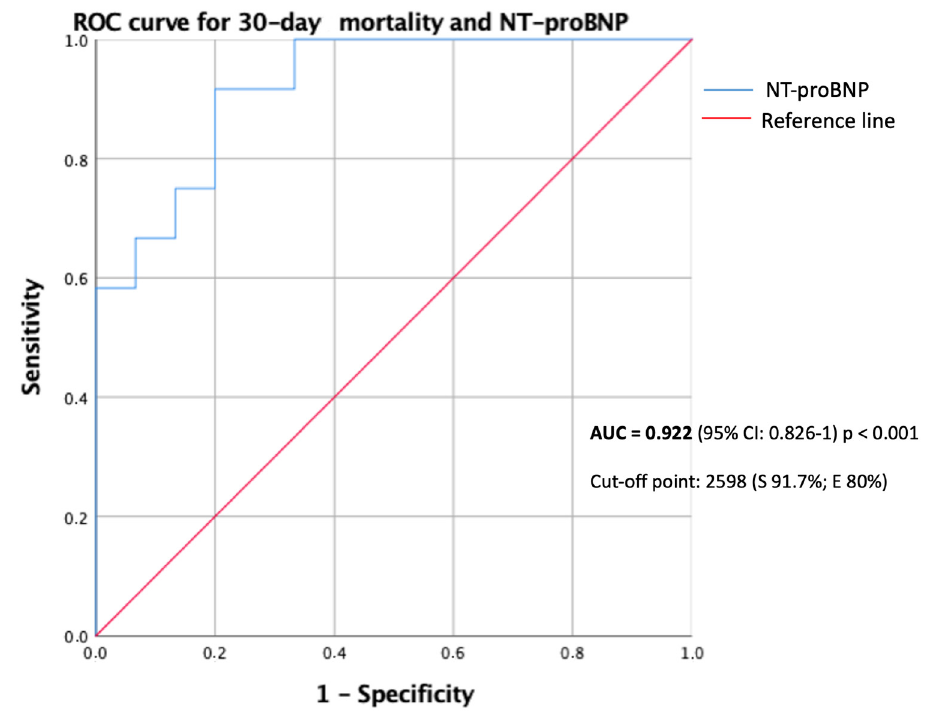
Figure 3. ROC (receiver operating characteristic) curve for 30-day mortality and NT-proBNP.